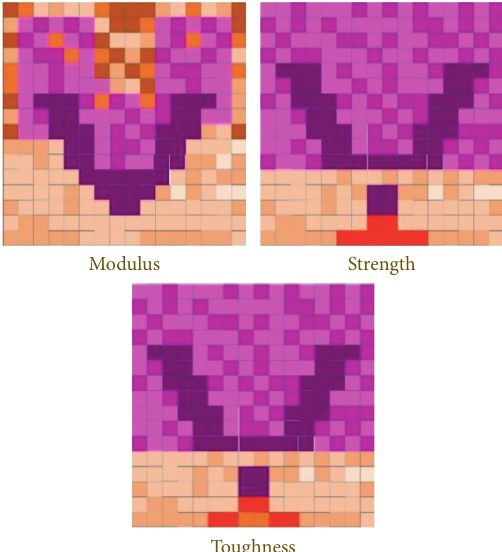
Figure 10: 16 × 16 weights ranking.